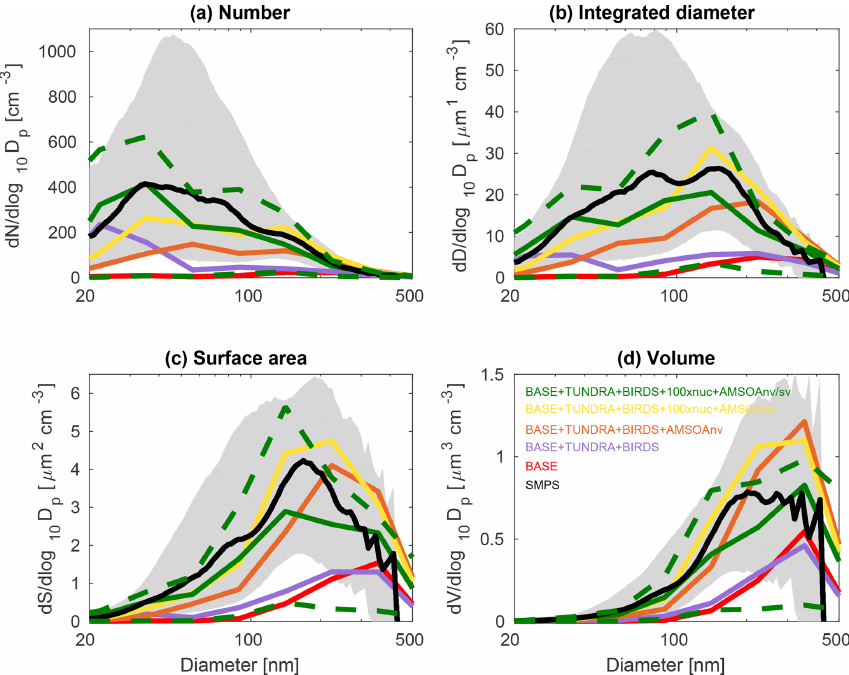
Figure 5. July and August 2016 median aerosol size distributions from scanning mobility particle sizer (SMPS) measurements for the CCGS Amundsen 2016 ship track (black; described in Sect. 2.1) and for five GEOS-Chem-TOMAS simulations (color coded as shown in the legend). Grey shading shows the SMPS 20th to 80th percentile and the green dashed lines show the 20th to 80th percentile for the BASE + TUNDRA + BIRDS + 100xnuc + AMSOAnv/sv simulation. Simulations are described in Table 1 and Sect. 2.3. The panels show the aerosol distribution moments with respect to (a) the aerosol number, (b) the integrated aerosol diameter, (c) the aerosol surface area, and (d) the aerosol volume distributions. Note the different vertical scale relative to Figs. 3 and 4.